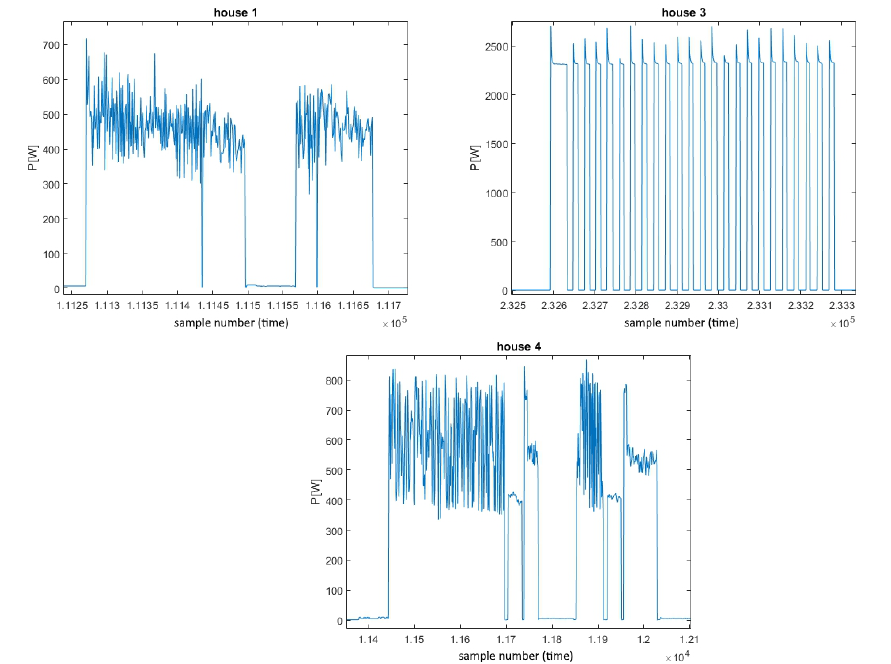
Figure 7. Washer dryer power consumption from different REDD dataset